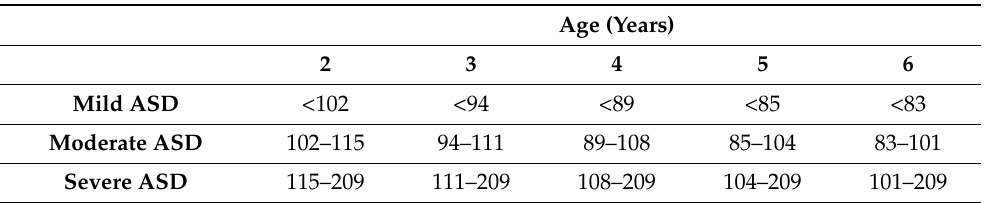
Table 10. Approximate relationship between MSEC + ATEC total scores, age, and ASD severity. At any age, a greater score indicates greater ASD